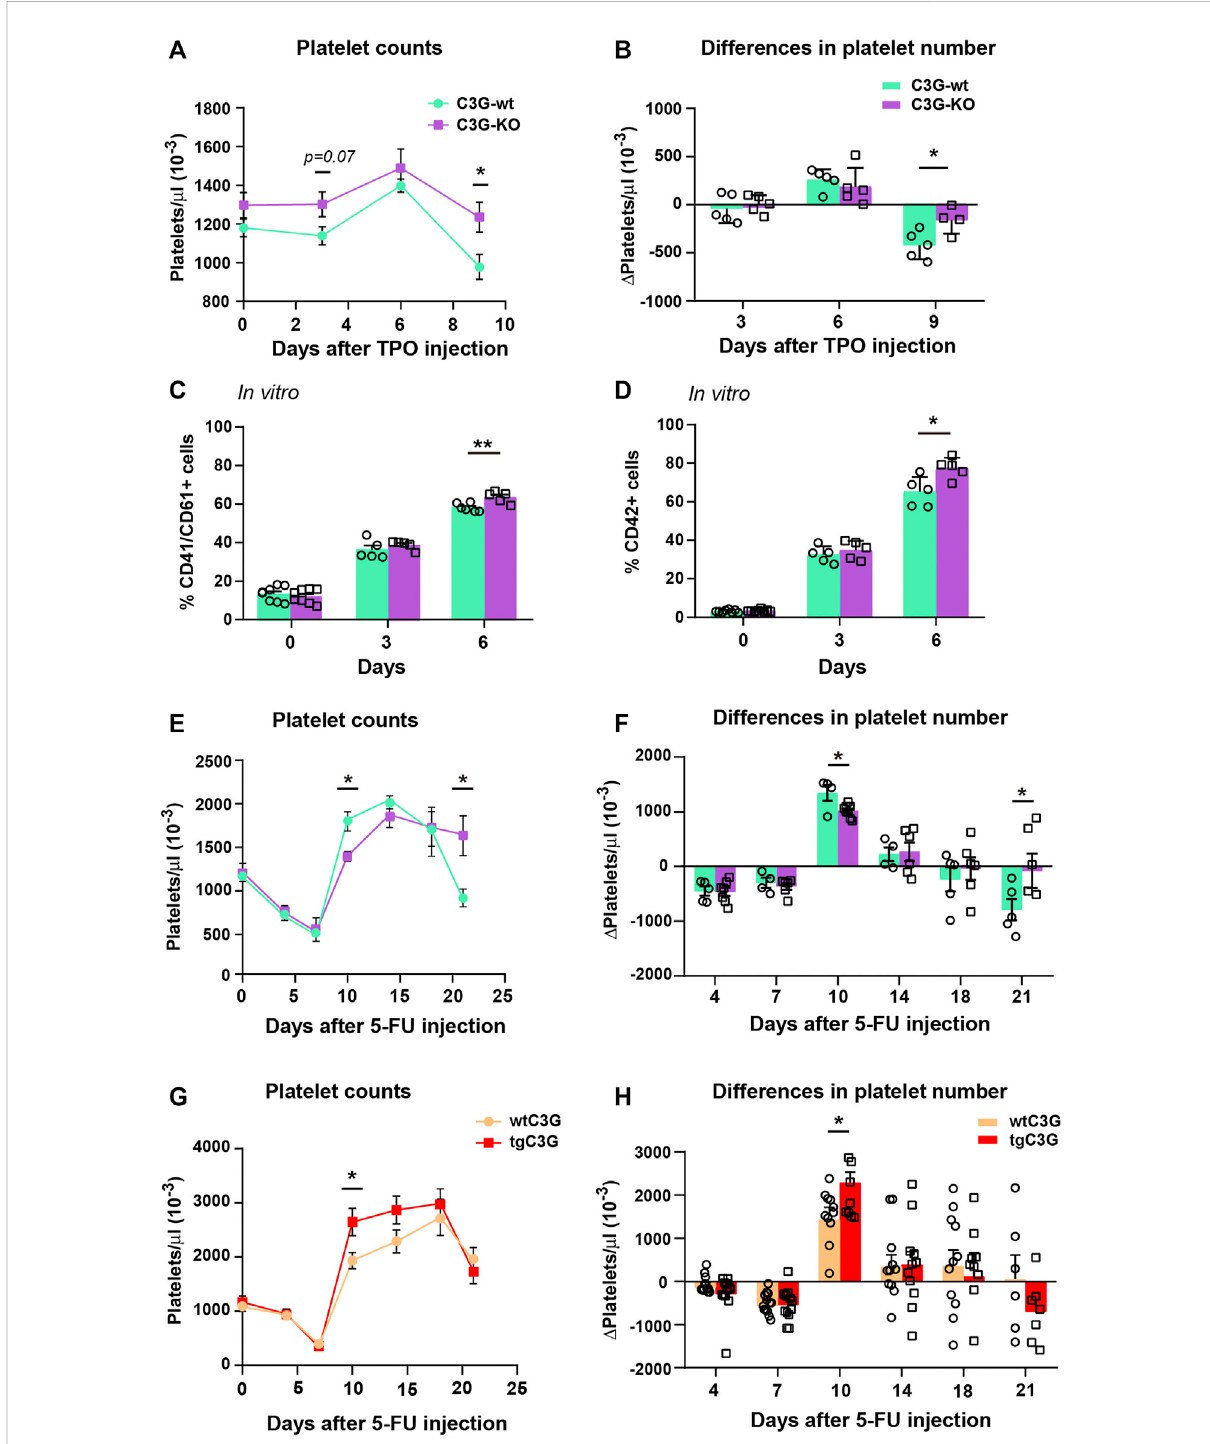
FIGURE 4 C3GregulatesplateletlevelsafterTPOinjectionor5-FU-inducedplateletrebound. (A) .Line/scatterplotsofthemean±SEMofplateletcountin C3G-KO and C3G-wt mice at the indicated time points after TPO injection (n=9 C3G-KO and C3G-wt). (B) Differences in platelet number between two consecutive measurements in each genotype, as an indication of the increased or decreased rate. (C,D) Mean ± SD of the percentage of total (CD41 + /CD61 + ) MKs (C) or mature (CD42 + ) MKs (D) in BM cultures of C3G-KO and control mice, at the indicated time points. (E,G) Line/scatter plots of themean ± SEM of platelet count inC3G-KOand C3G- wt mice (E) or intgC3Gand wtC3Gmice (G) attheindicated time points after 5-FU- injection (n=8 C3G-KO and C3G-wt; n=12 tgC3G, n=13 wtC3G). (F,H) Differences in platelet number between two consecutive measurements in each genotype, as an indication of the increased or decreased rate. * p < 0.05, ** p <